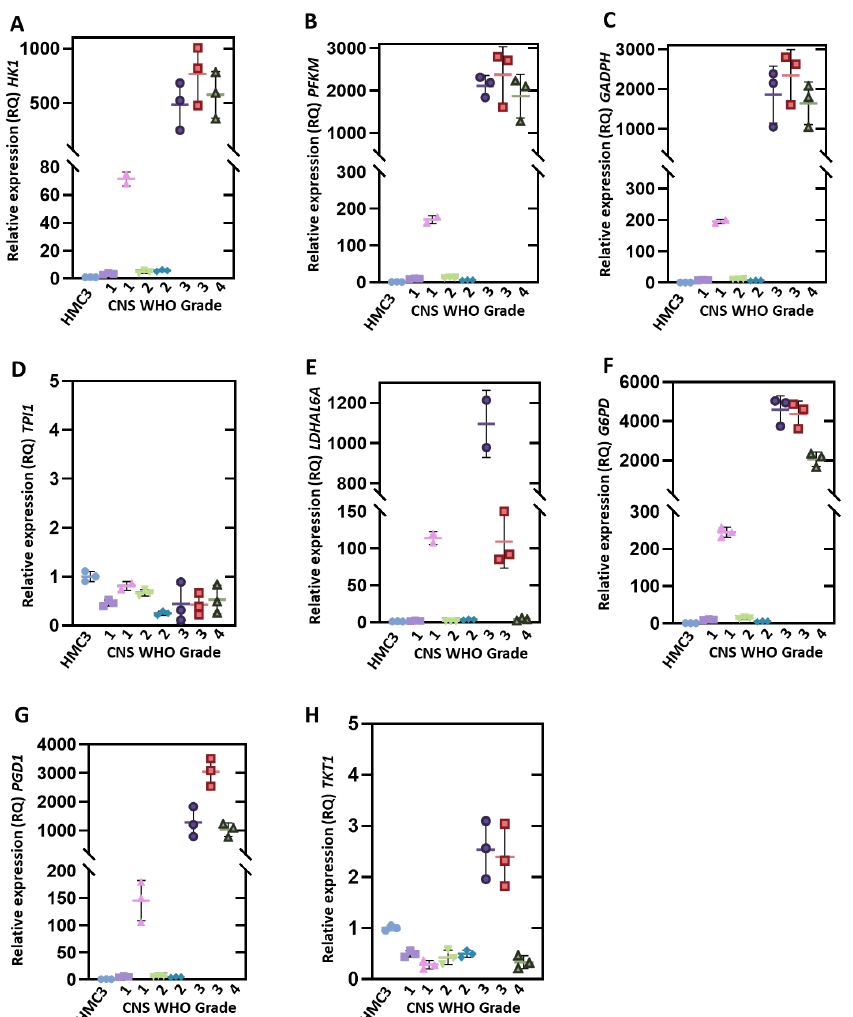
Figure 2. Differential expression of genes involved in essential metabolic pathways of glioma cells. ( A – E ) represent expression levels of the HK1 , PFKM , TPI1 , GAPDH , and LDHAL6A genes involved in glycolysis. ( F – H ) represent the expression levels of the G6PD , PGD1 , and TKT1 genes involved in pentose phosphate. Relative expression levels were determined using the PKM gene as a reference. Values are means ± SD of quadruplicate